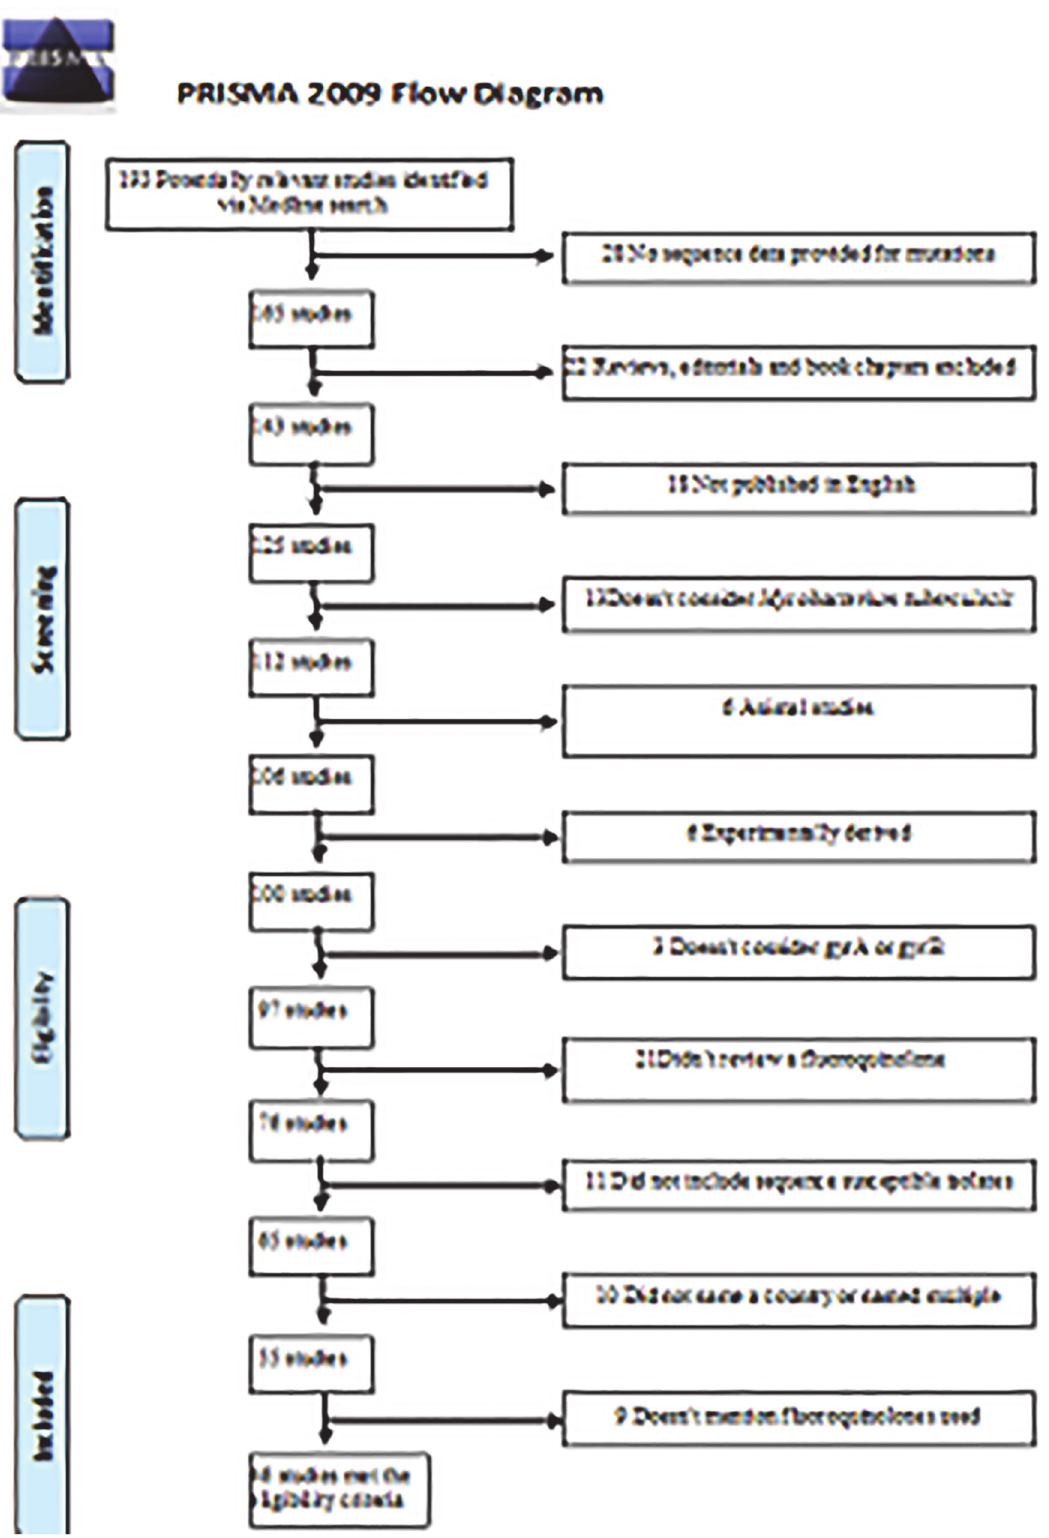
Fig 1. Study Selection Process and Reason for Exclusion of Studies.